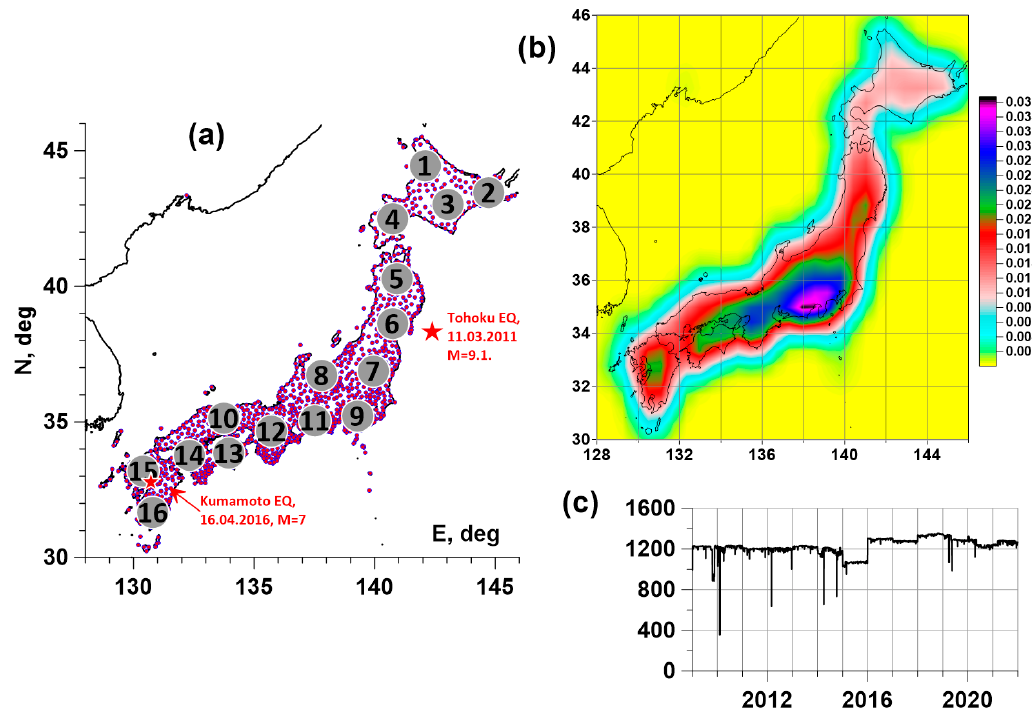
Figure 1. ( a )—position of GPS measurement points in Japan (purple dots) and positions of 16 reference points (grey circles), red stars indicate epicenters of Tohoku (11 March 2011, M = 9.1) and Kumamoto (16 April 2016, M = 7) earthquakes; ( b )—density of GPS stations; ( c )—daily numbers of operational GPS stations in Japan, 2009–2021.